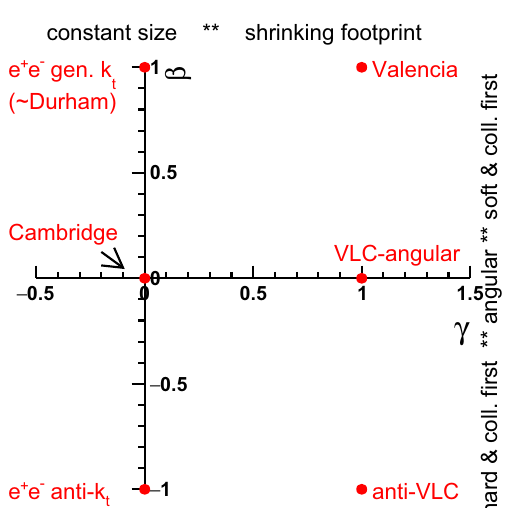
Fig. 4 Diagram of the parameter space spanned by exponents β and γ of the VLC algorithm. On the y -axis generalisations with beam jets of the LEP/SLD algorithms are found, with the Cambridge algorithm with angular ordering at the origin and the Durham or k t algorithm at β = 1. Choosing β = -1 yields reverses the clustering order (like in anti- k t algorithm [38]). Choosing non-zero and positive values for γ yields robust algorithms with a shrinking jet area in the forward region